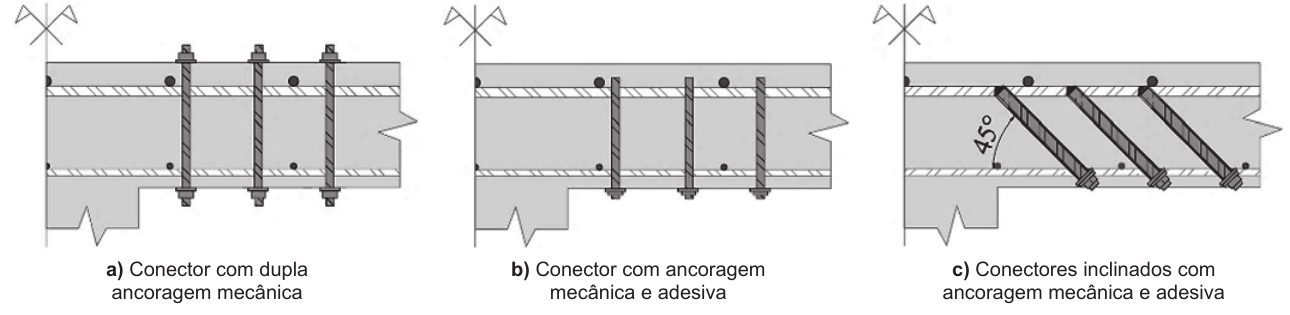
a) Conector com dupla ancoragem mecânica Figura 4 Tipos de reforço à punção para ligações lajes-pilar com conectores pós-instalados de aço